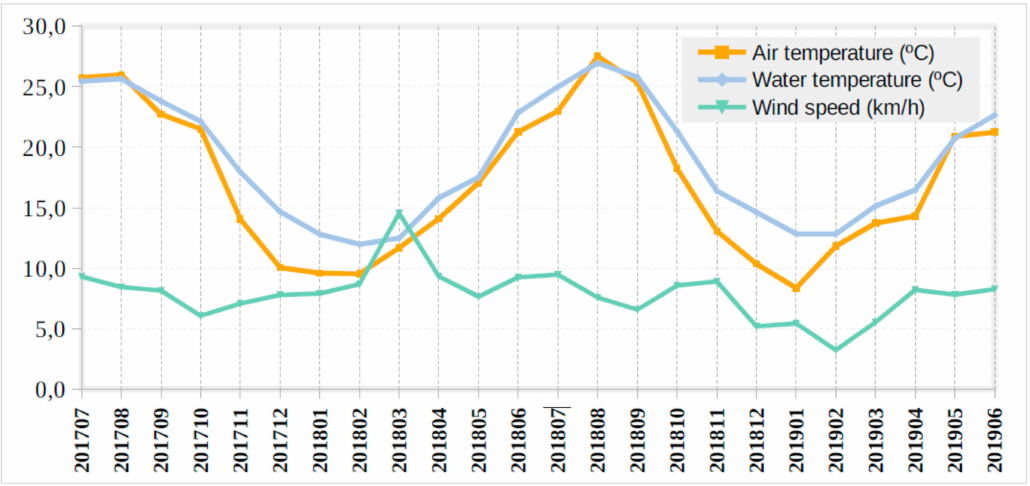
Figure 12. Monthly average of water temperature, air temperature and wind speed at the Alqueva